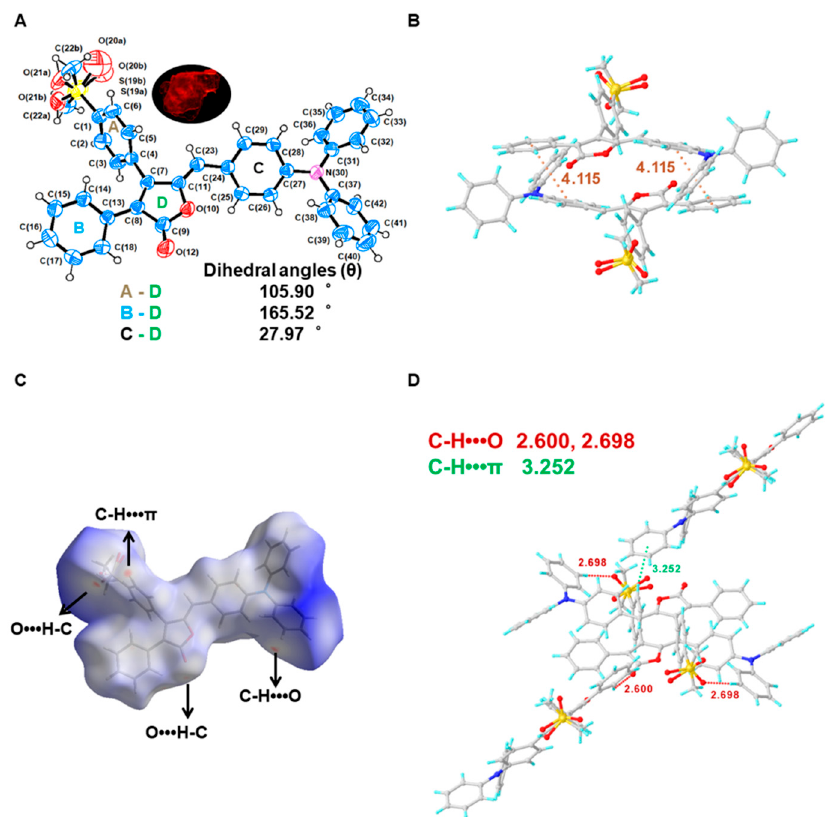
Figure 3. ( A ) ORTEP diagram and relevant dihedral angles of compound BY1 (50% ellipsoidal probability). ( B ) Centroid distance of benzene ring between adjacent molecules. ( C ) The Hirshfeld surfaces of BY1 mapped with d norm . ( D )The interactions between adjacent molecules.